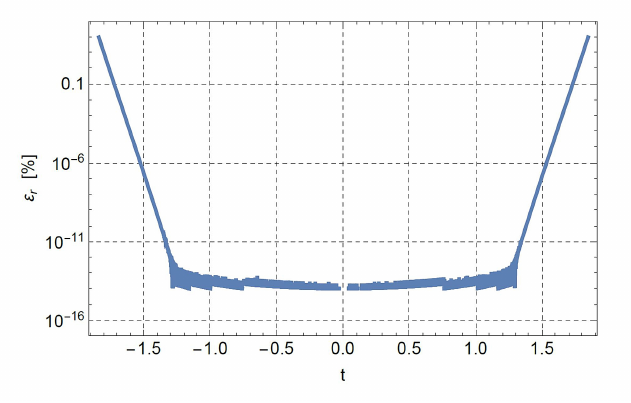
Figure 2. Relative percentage error of the Bell’s approximation of F ( t ) in (27).